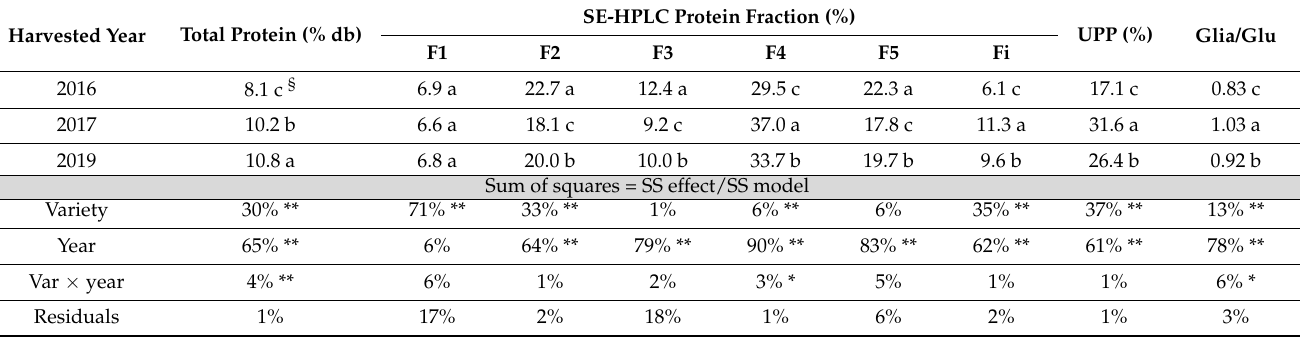
Table 5. Means of the protein quality parameters measured on ground grains (lab-milled grains) of cvs Anvergur, Claudio, Bidi17 and LA1823 grown under zero-input conditions and harvested in Mauguio in 2016, 2017 and 2019.